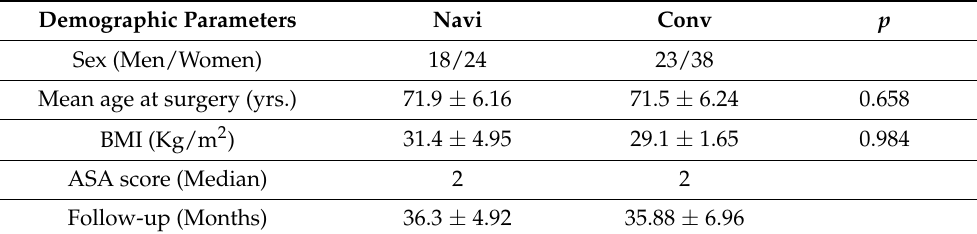
Table 1. Demographic